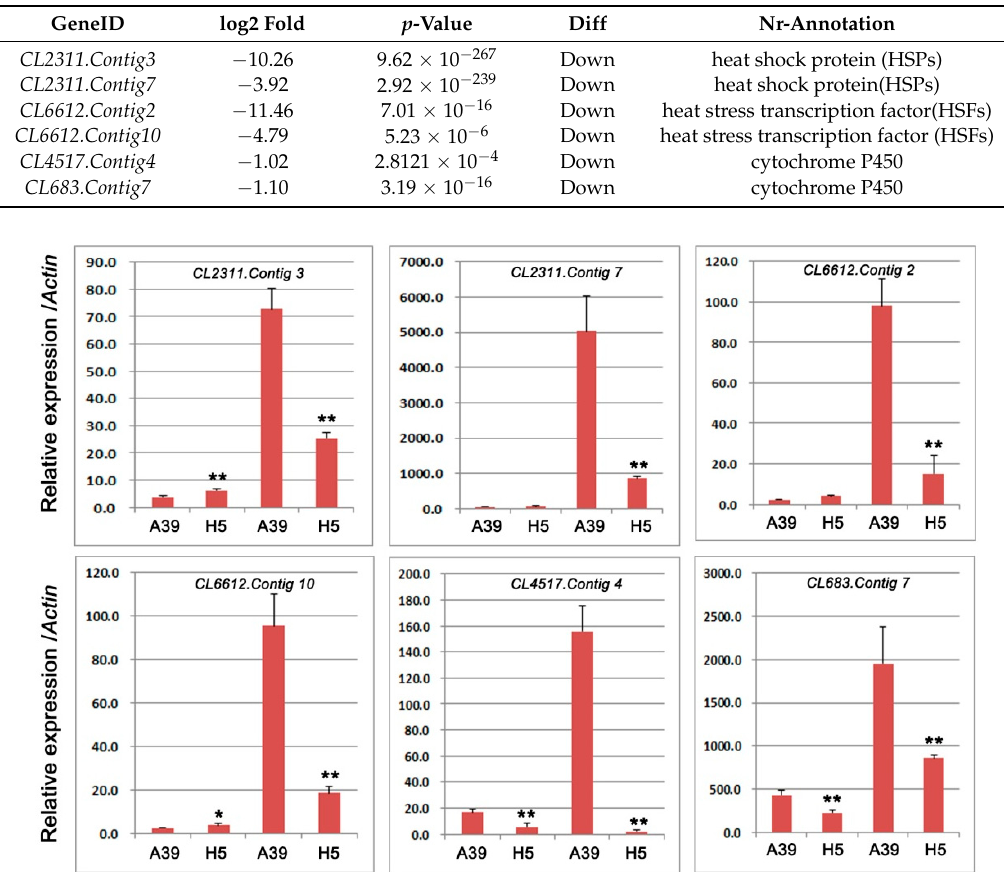
Table 2. Genes related toHSPs, HSFs, and cytochrome P450.